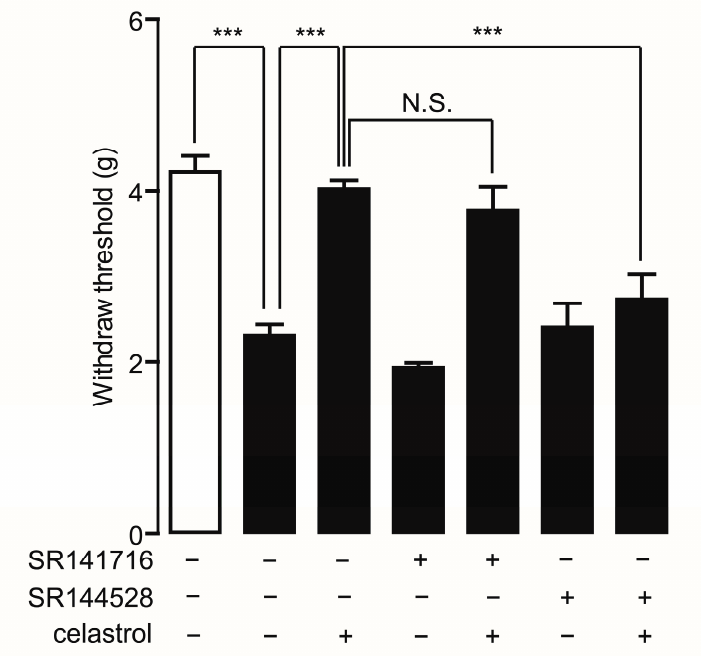
Figure 2. Analgesia effect of celastrol in carrageenan-induced inflammatory pain was mediated by cannabinoid receptor-2 (CB ) signaling. The effects of celastrol, SR141716, 2 SR144528, a combination of celastrol and SR141716 and a combination of celastrol and SR144528 on mechanical hyperalgesia, assessed by the allodynia test, in carrageenan-injected mice (closed bar). Open bar, non-carrageenan injected mice; vehicle, 5% PEG/5% Tween-80 in saline, 10 mL/kg, i.p; celastrol, 0.3 mg/kg, i.p.; SR141716, 1 mg/kg, i.p.; SR144528, 1 mg/kg, i.p. *** p < 0.001; N.S., not significant; one-way ANOVA followed by Bonferroni’s multiple comparison test, n = 8.